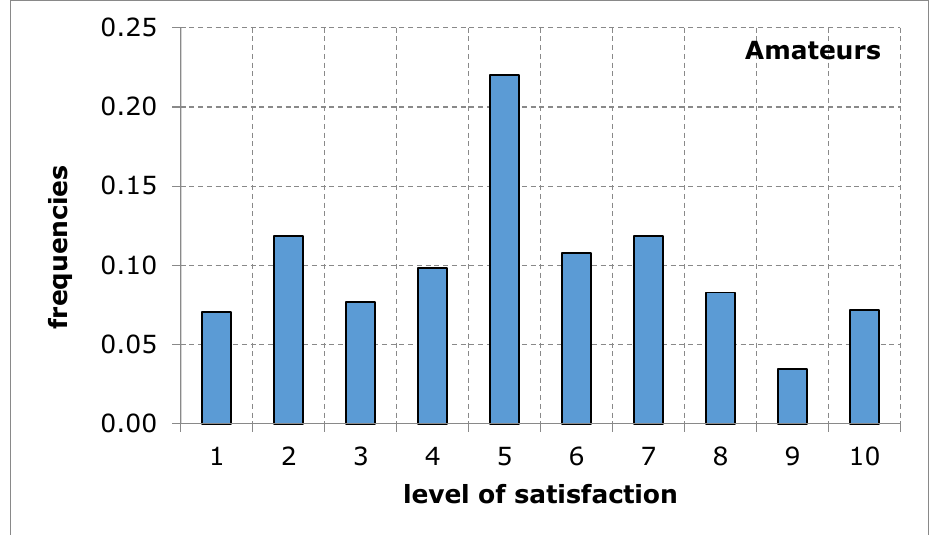
Figure 1. A sports and recreation facility is not publicly available to residents of the city of Poznan, in the opinion of service recipients (Amateurs). Source: own work.